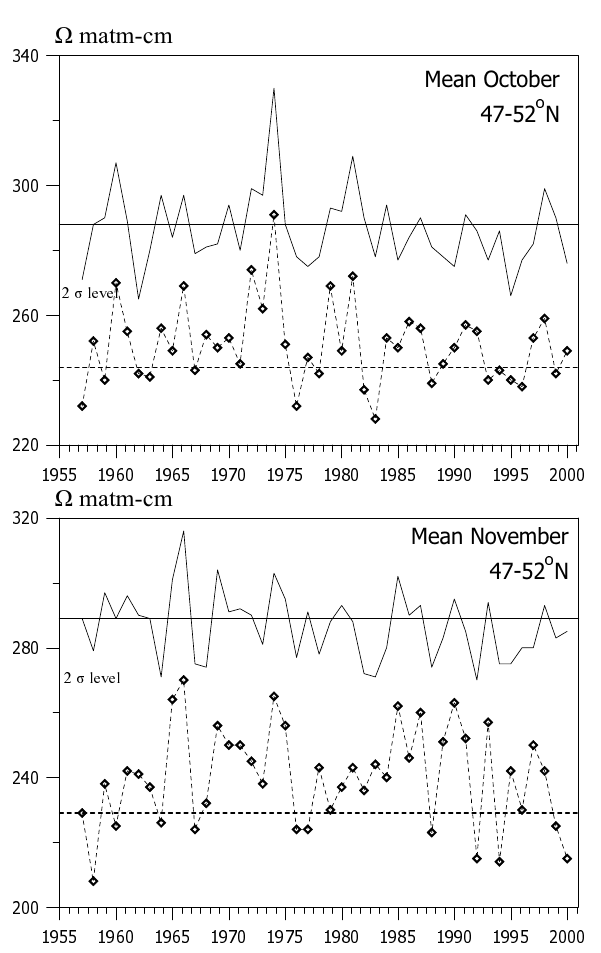
Fig. 2. Monthly mean October (upper panel) and November (Lower panel) total ozone values for the years 1957–2000 from ground- based stations within the 47–52 ◦ N belt (solid line). The dashed line shows the 2 σ levels of the daily values and the diamonds indicate the minimum values reported.